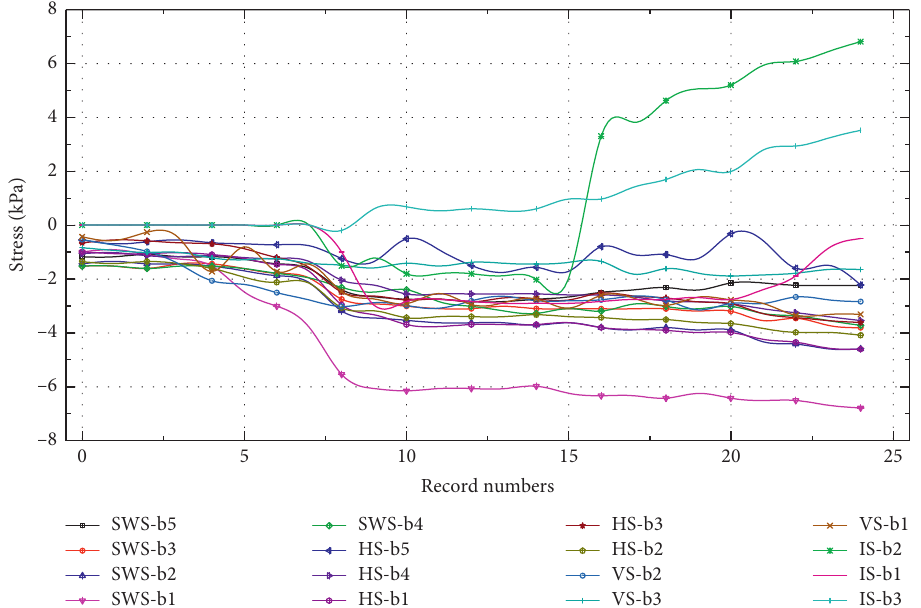
Figure 12: Stress-change curves of the surrounding rock and second lining.